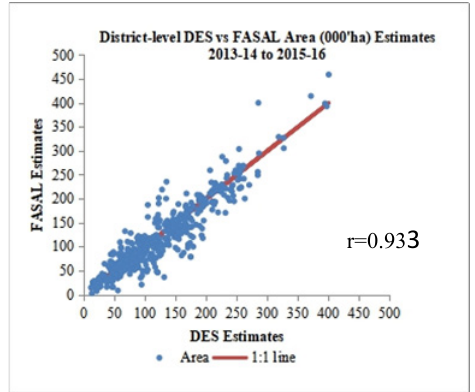
0.92 respectively as predicted from Figure 9, Figure 10 & Figure 11. Correlation coefficient values for yield was low may be due to heavy rainfall and hailstorm events occurred in major wheat growing areas of the country during February and March 2015.